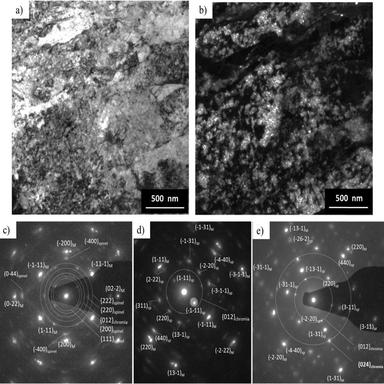
(a) Bright-field (BF) and (b) corresponding centred dark-field (CDF) TEM images; and associated selected area diffraction patterns (SADP) on zone axes for (c) , (d) and (e) obtained from a region of the FIB fracture surface lift-out sample containing an M3O4-type structure (spinel) and Cr2O3. The objective aperture of the SADP in (d) indicates the reflection of the M3O4-type oxide used to acquire the CDF image in (b).